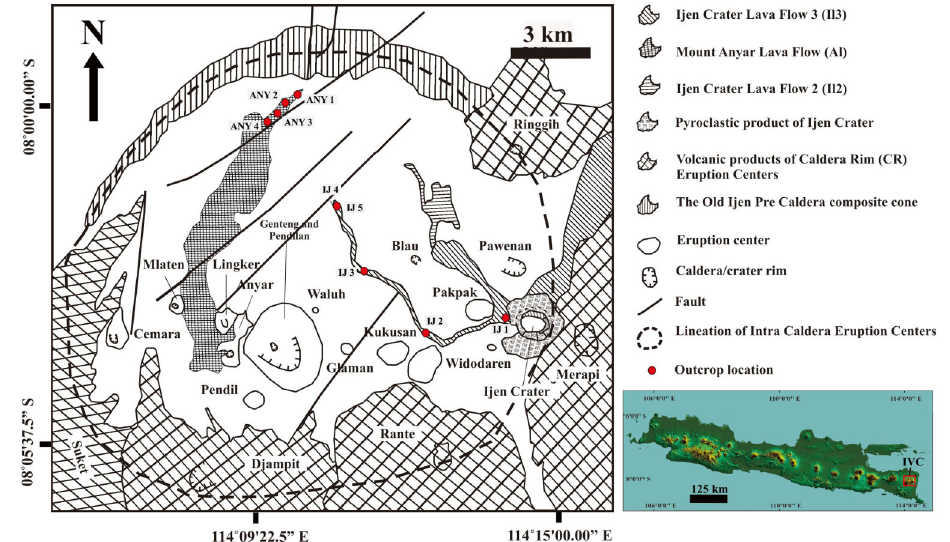
Figure 1. The Ijen Volcanic Complex (IVC) map shows the geographical layout of the eruption centers and the distribution of the volcanic products of some eruption centers [24,27]. Red dots show lava outcrops. Shuttle Radar Topography Mission (SRTM) satellite images were obtained from Earth Data